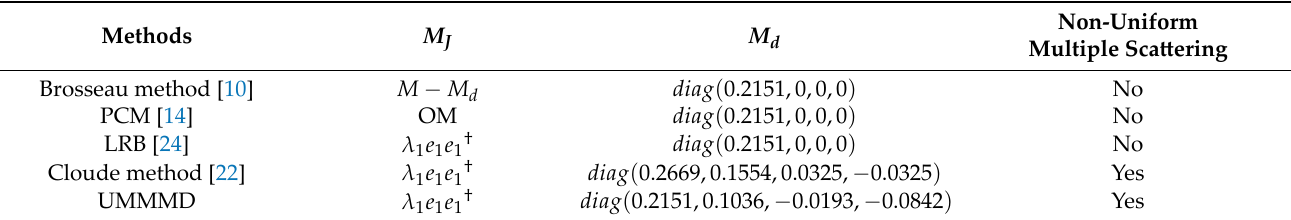
Table 2. Comparison between UMMMD and some